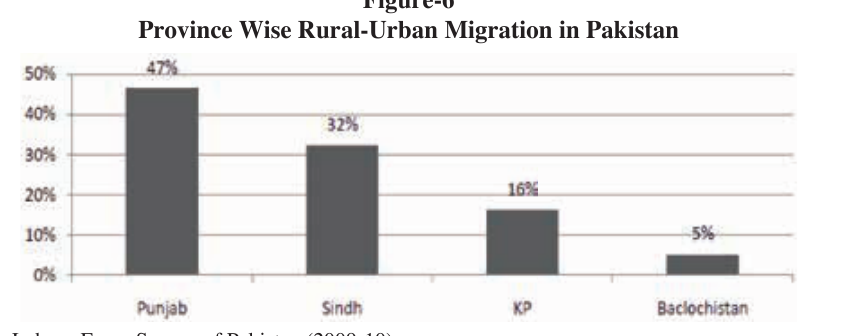
Figure-6 Province Wise Rural-Urban Migration in Pakistan